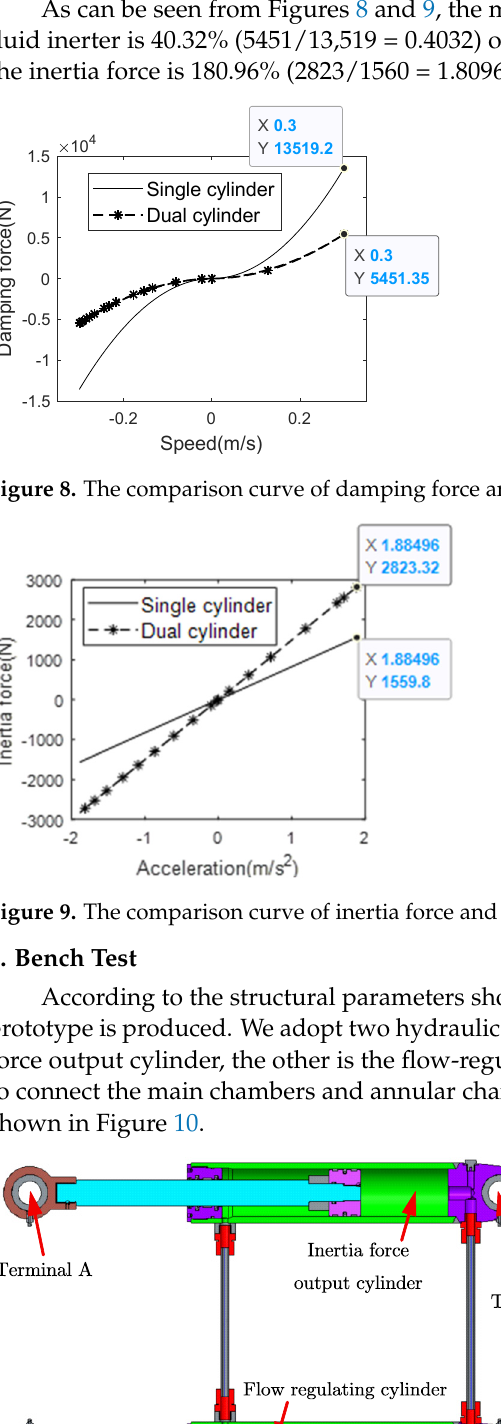
Base Figure 11. Prototype of dual-cylinder fluid inerter.